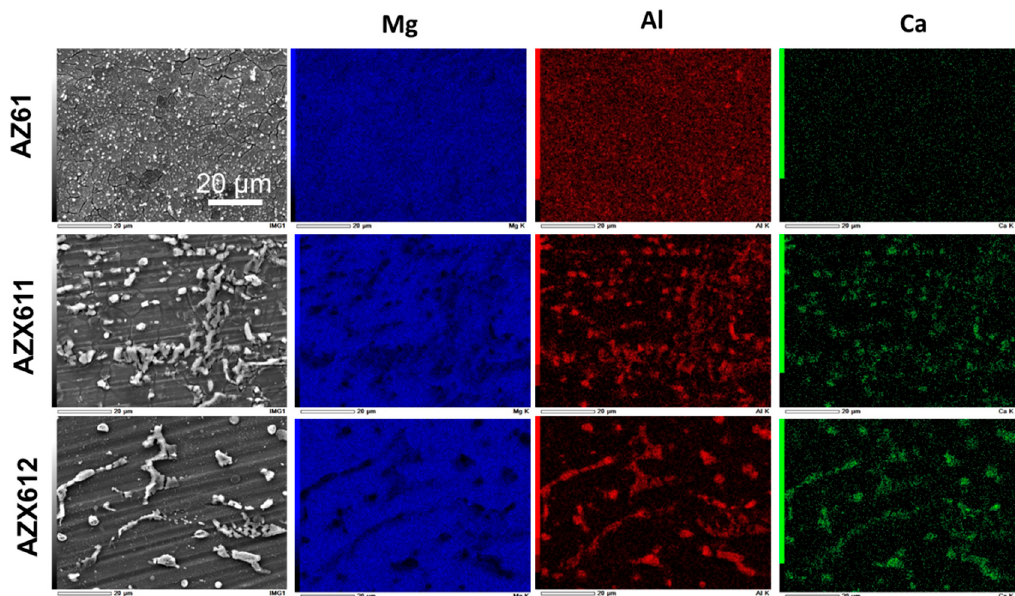
Figure 2. Plane-view SEM images and the corresponding EDS maps for Mg (blue), Al (red), and Ca (green), of AZ61, AZX611, and AZX612 alloys. The scale bar applied to all images.